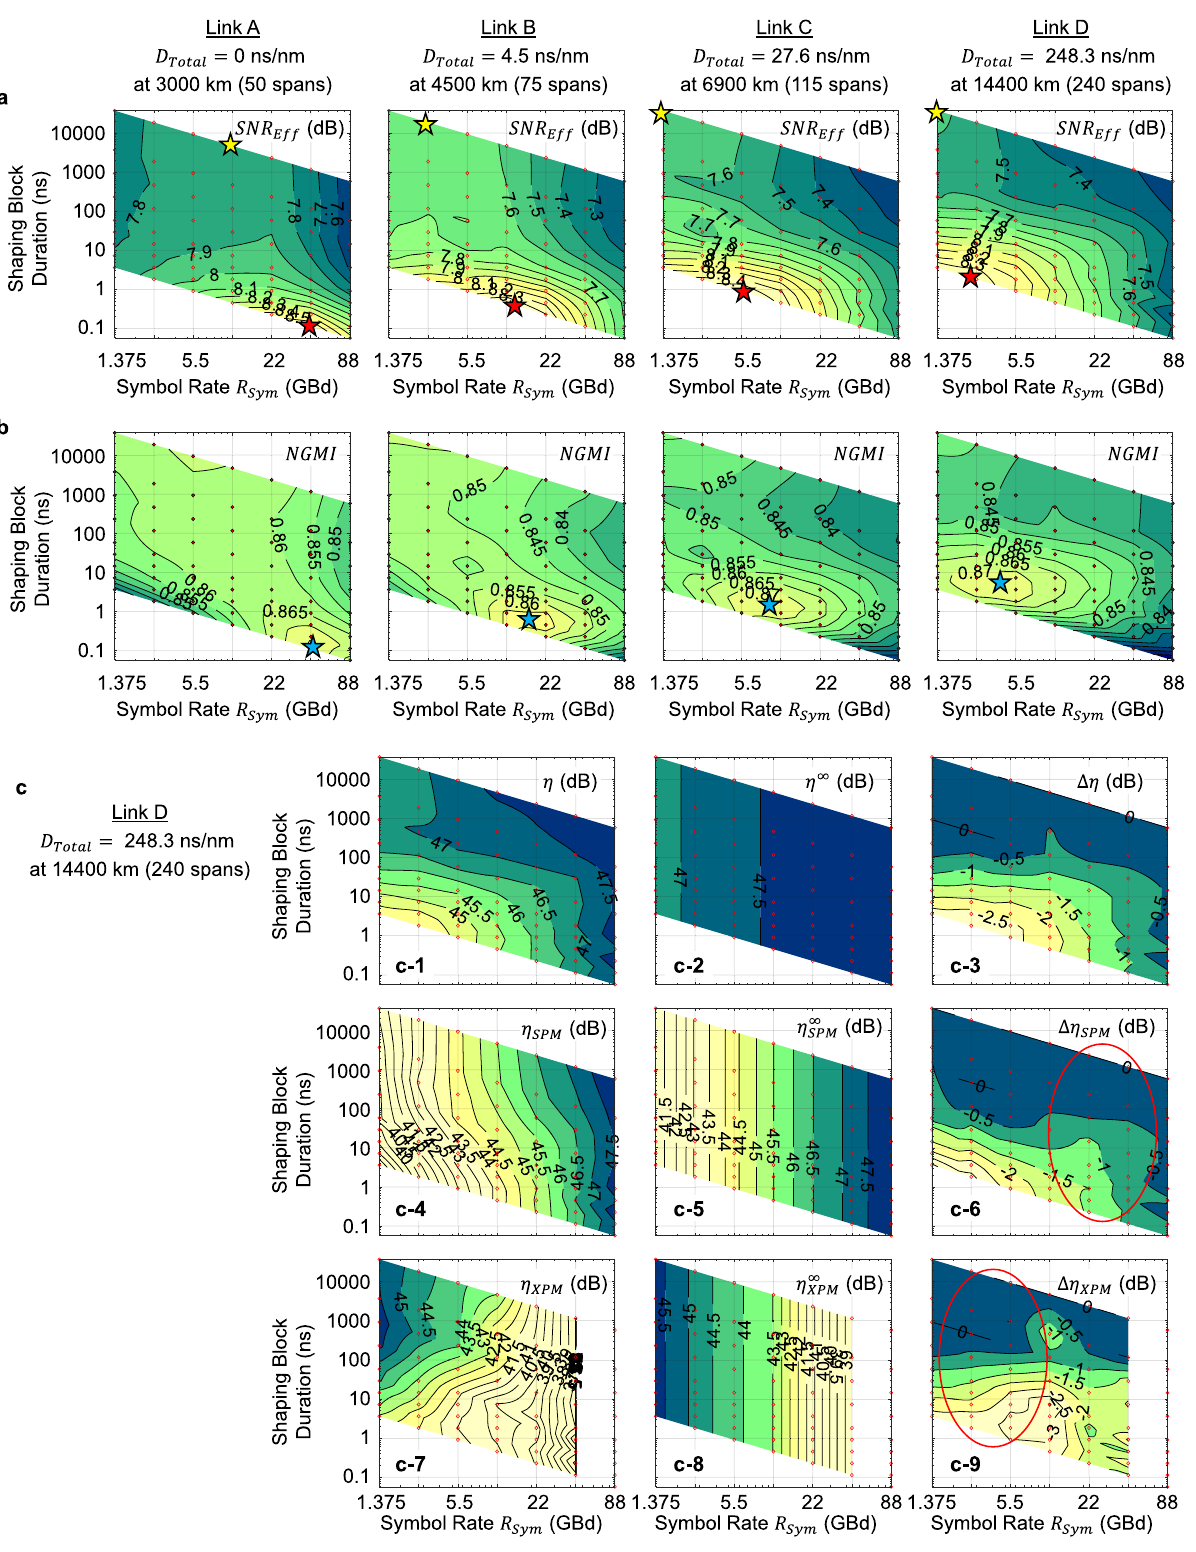
Fig. 2 Split-step simulation with various spectro-temporal division of lightwaves. a Effective SNR drawn as a function of the symbol rate (spectral division) and shaping block duration (temporal division). b NGMI showing the end-to-end performance, produced by the complex interaction of the propagation effect and the fundamental energy ef fi ciency of the underlying sphere shaping. c NLI coef fi cient η and its decompositions into SPM contribution η SPM and XPM contribution η XPM , and into factors due to i.i.d. shaping η 1 and fi nite-length shaping Δ η . Source data for Fig. 2 are provided with this